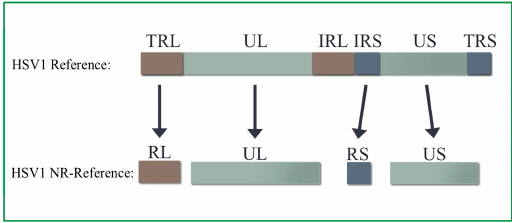
Figure 2. Full-length HSV1 reference genome and HSV1 NR-reference genome. The strain 17syn+ HSV1 genome (GenBank Accession Number: NC_001806) consists of two unique regions, referred